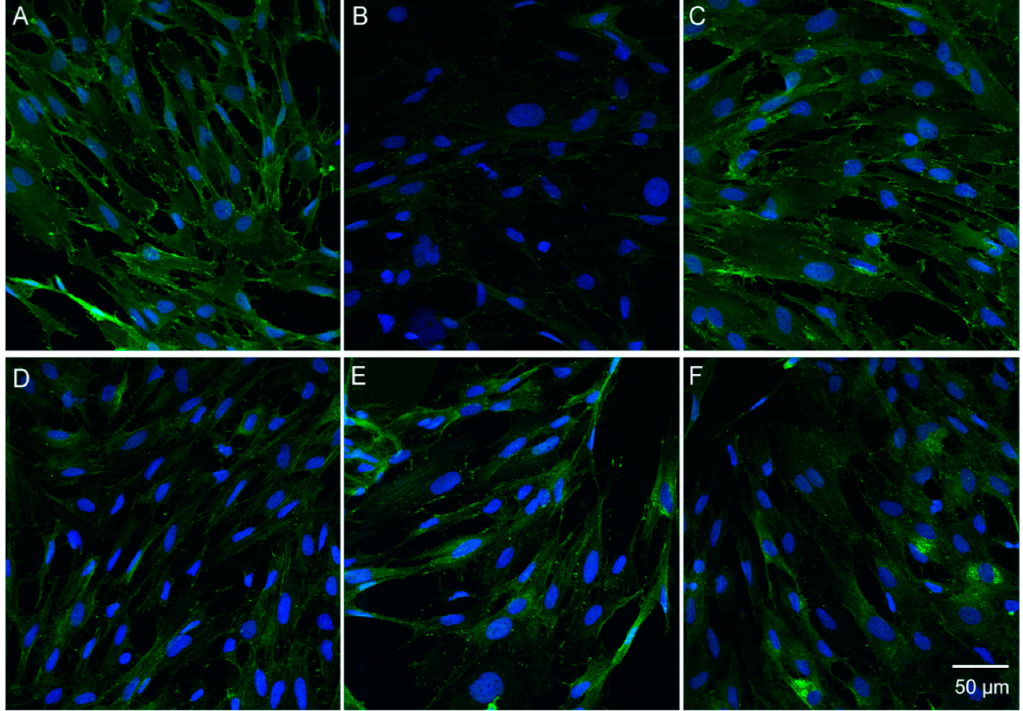
Figure 8. The effects of catalpol on Claudin-5 decreased expression induced by LPS detected by immunofluorescence staining. ( A ) normal group; ( B ) model group; ( C ) Fasudil group; ( D ) catalpol 0.3 μ M group; ( E ) catalpol 3.0 μ M group; ( F ) catalpol 30.0 μ M group.